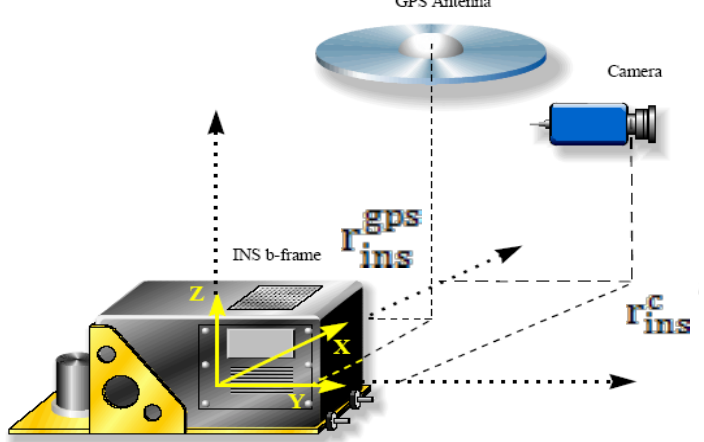
Figure 7. Concept of lever arm